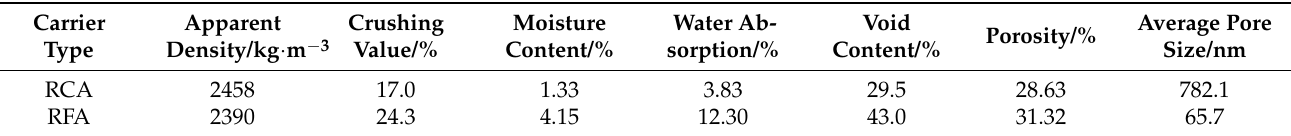
Table 2. Physical properties of recycled aggregate